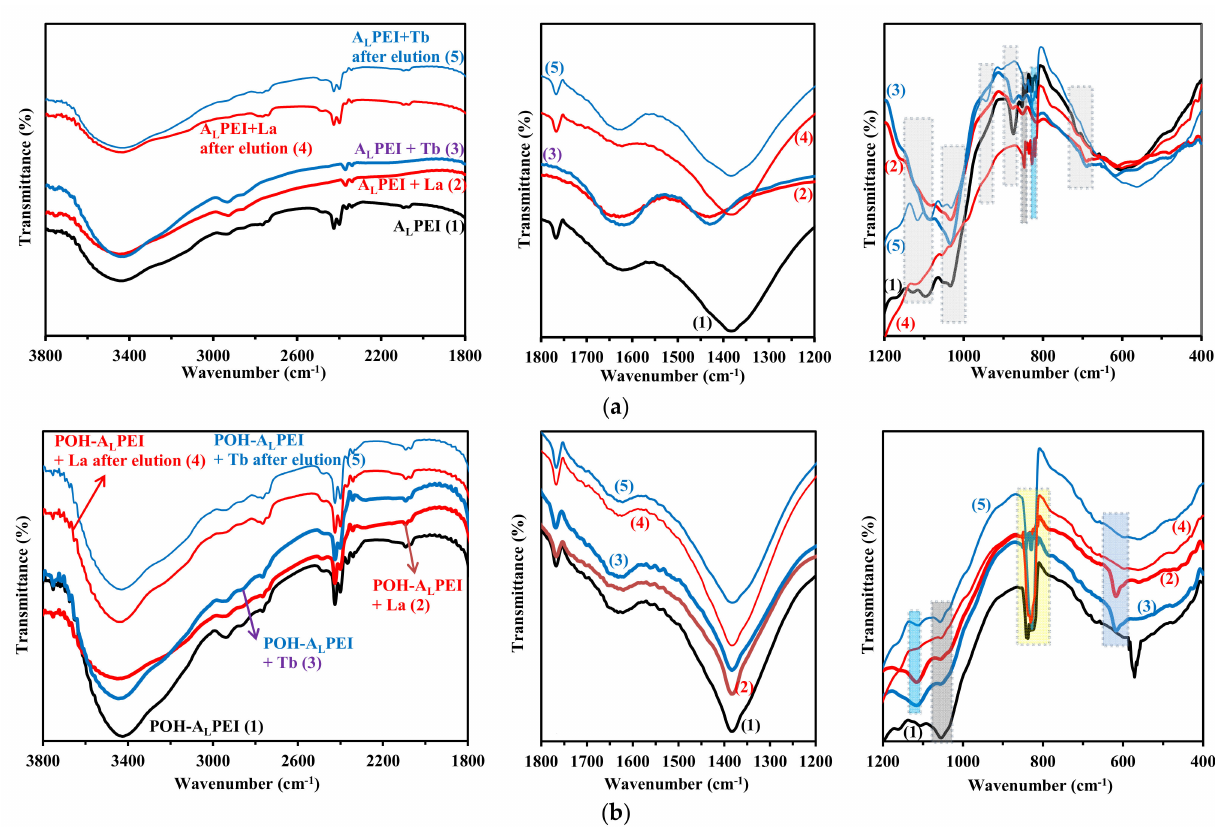
Figure 8. FTIR spectra of A L PEI ( a ) and POH-A L PEI ( b ), before metal sorption and after metal desorption (focus on different wavenumber